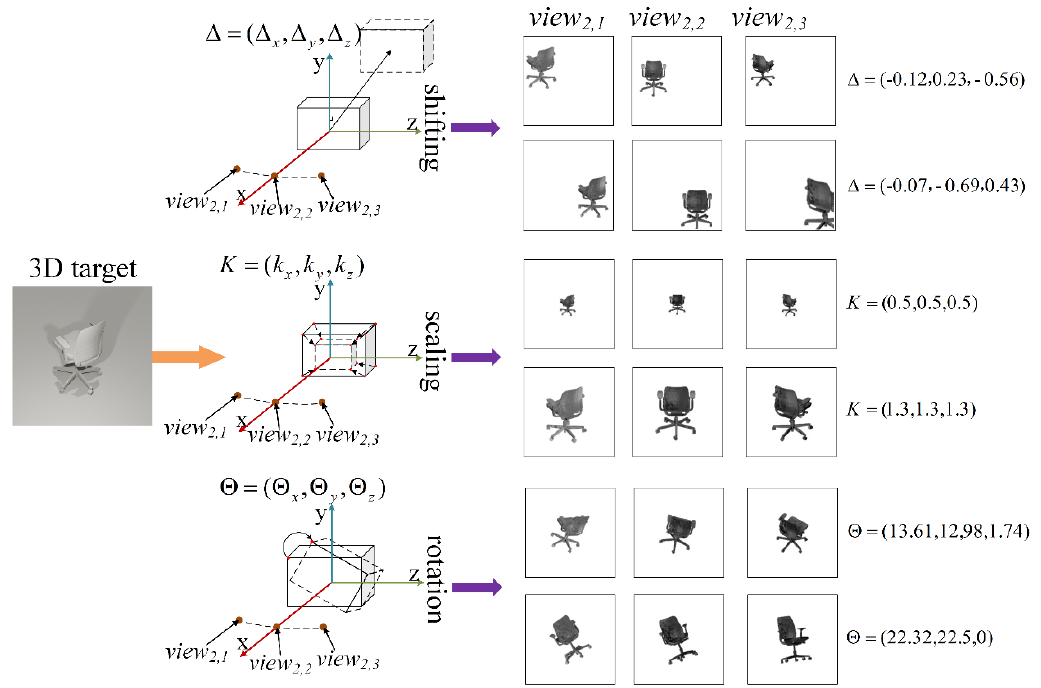
Figure 7. Illustration of target transformation.